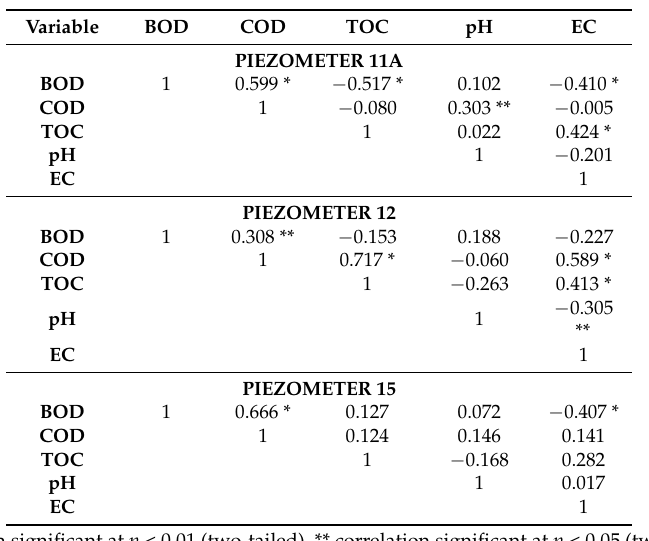
Table 5. Pearson’s correlation analysis between selected pollution indicators based on monitoring data from piezometers located within the composting area.